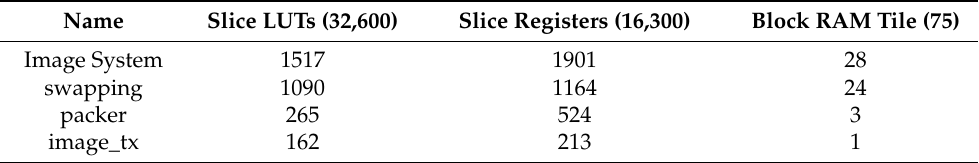
Table 7. XC7A50T FPGA